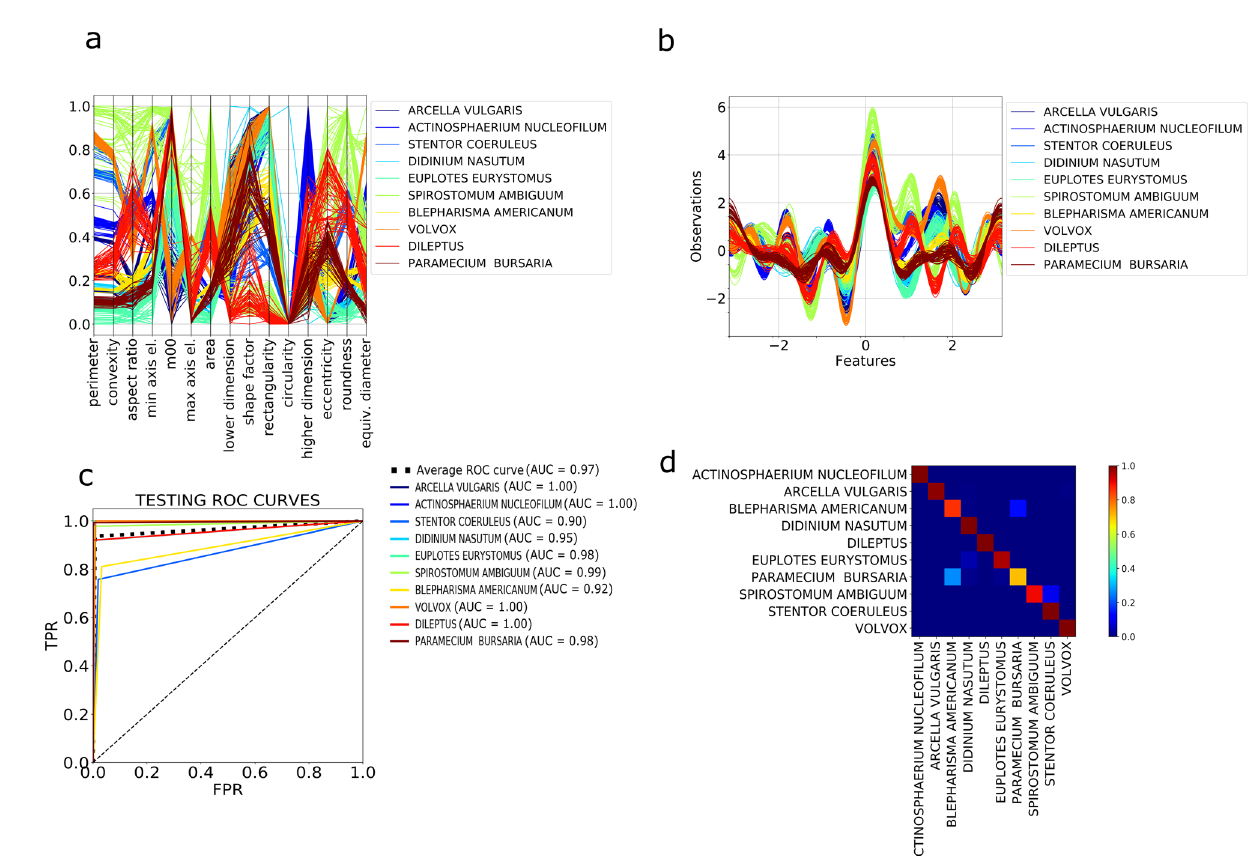
Figure 3. Feature space representation and classification performances. a , b Multidimensional visualization of the geometric subset of the ten species in the lensless microscope dataset, obtained using the following methods (see Supporting Information): a Andrew’s curve. b Parallel coordinates. c ROC curves obtained for the neural network classifier trained on the labels provided by the clustering algorithm for the lensless microscope dataset. d Corresponding confusion